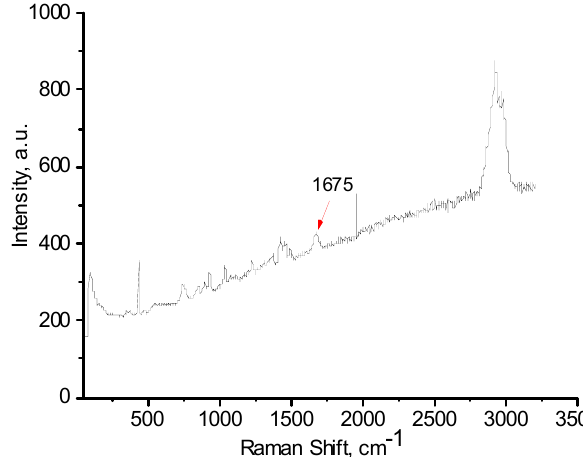
Figure 11. Raman spectrum of PVP 40 kDa-AuNPs.